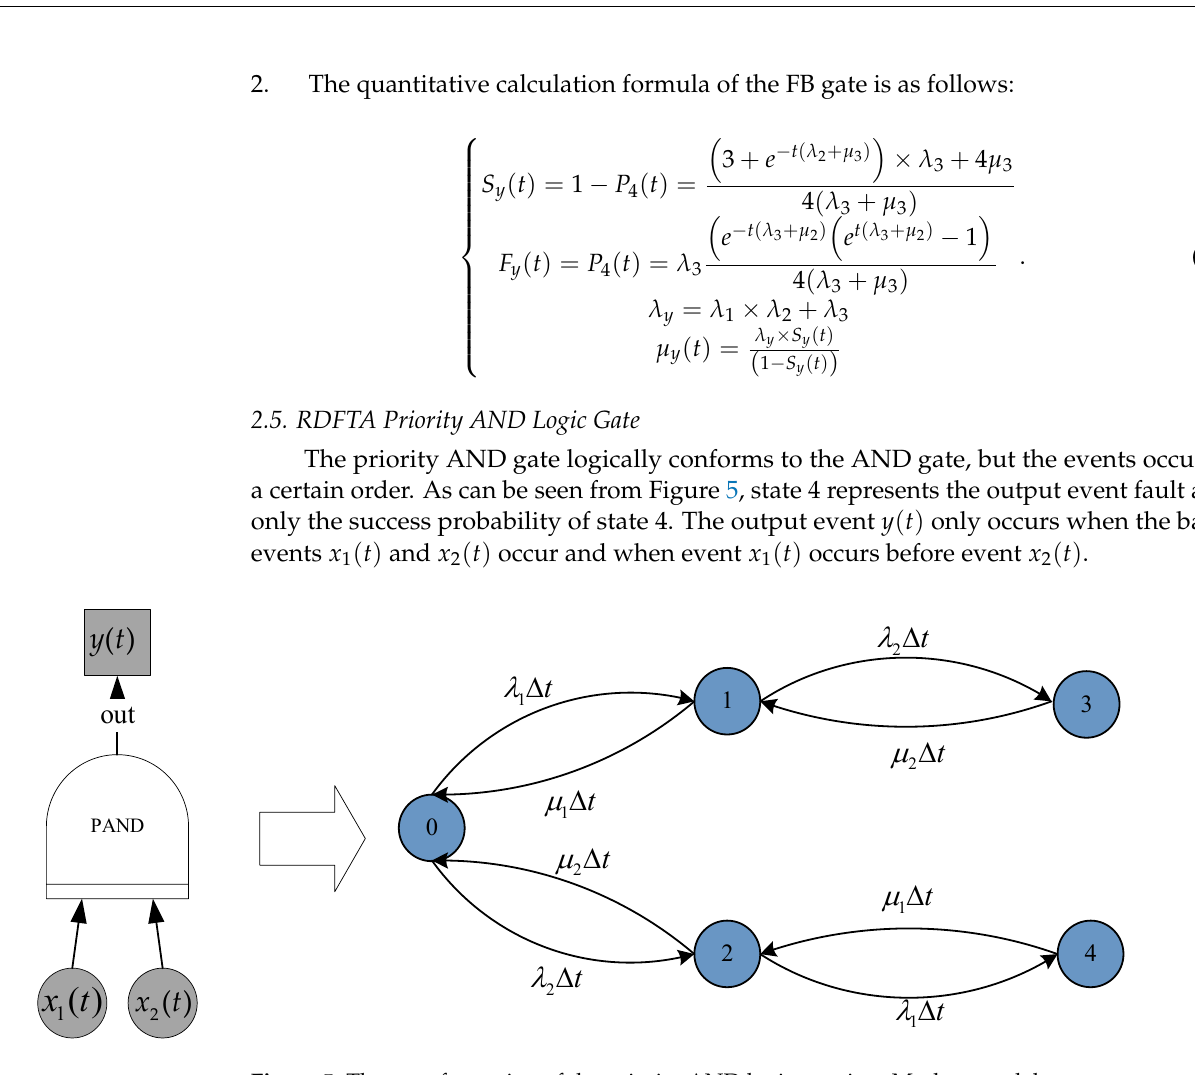
is the failure x ( i )